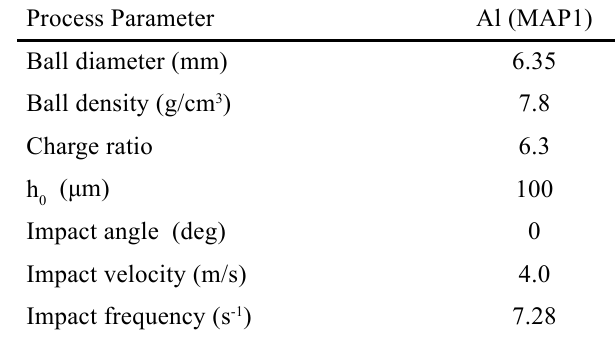
Table 1. The used parameters in model [23]